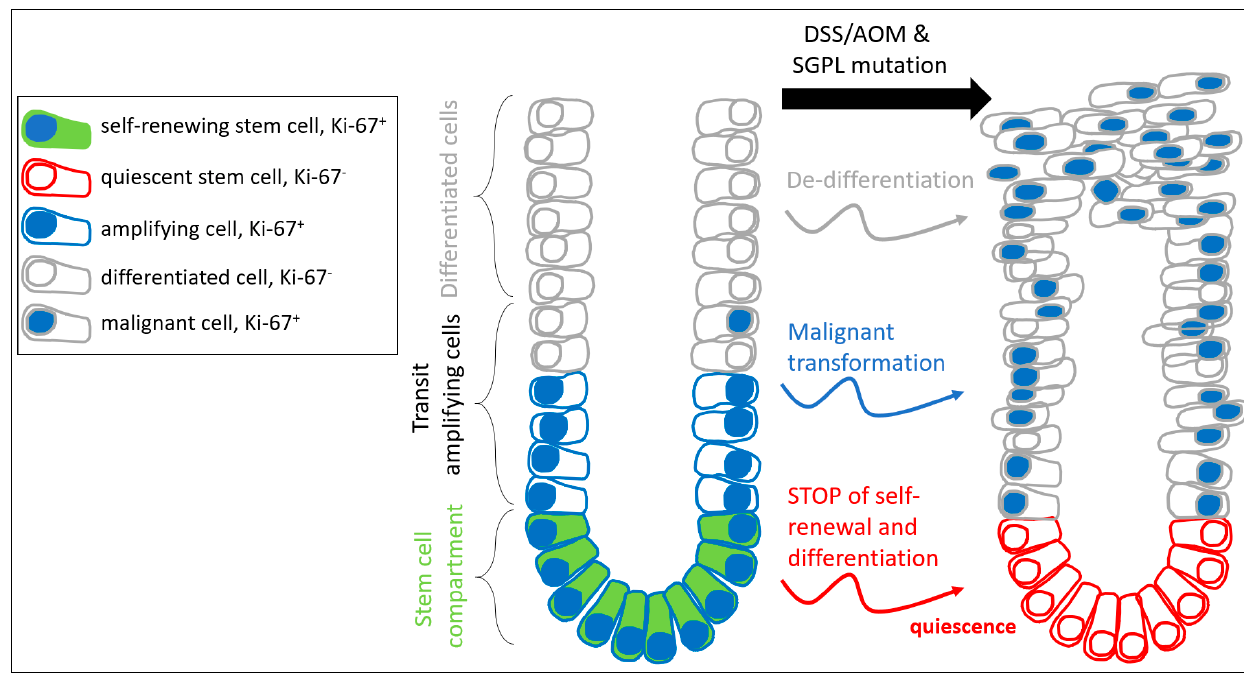
Figure 7. Scheme of S1P lyase mediated cell transformations during colitis-associated colorectal cancer progression.